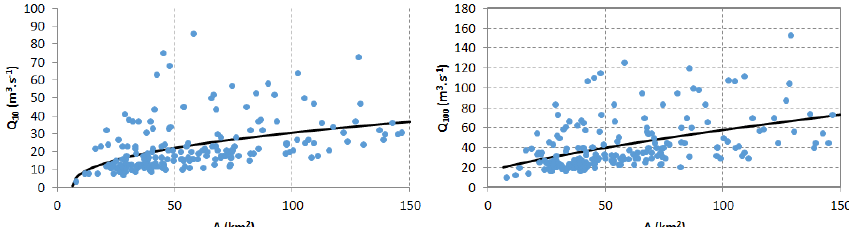
Figure 2. Relationship between catchment area and peak discharge value for T = 10 years (left panel) and T = 100 years (right panel) with fitted lines following Eq. (2).